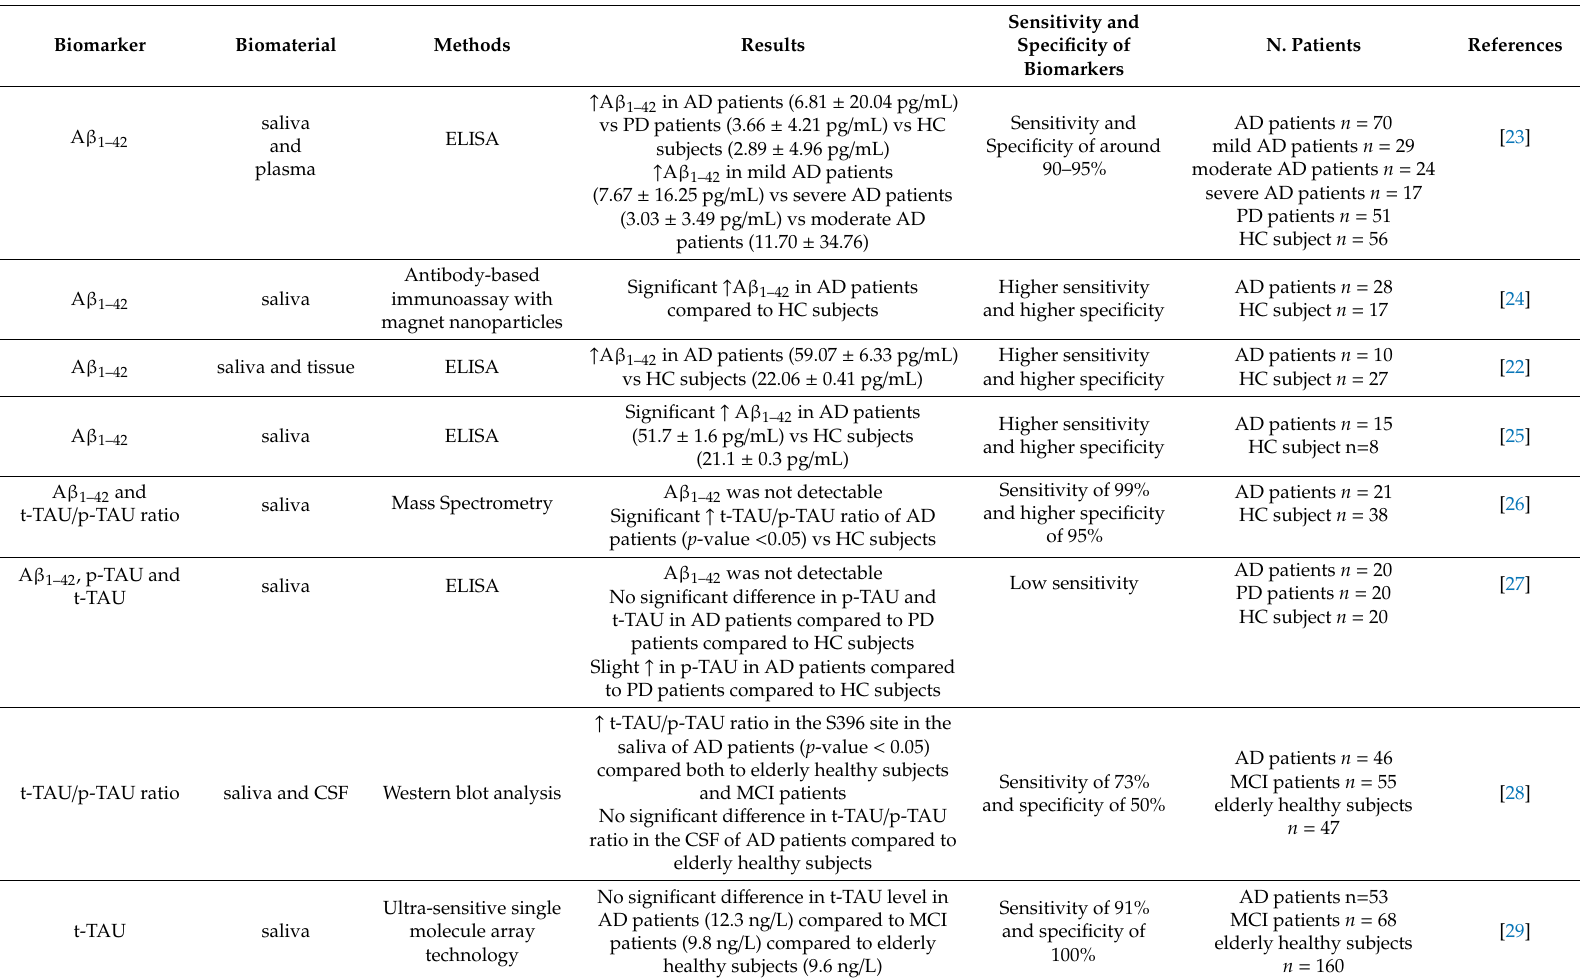
Table 1. Salivary biomarkers associated with Alzheimer’s disease (AD) described in clinical